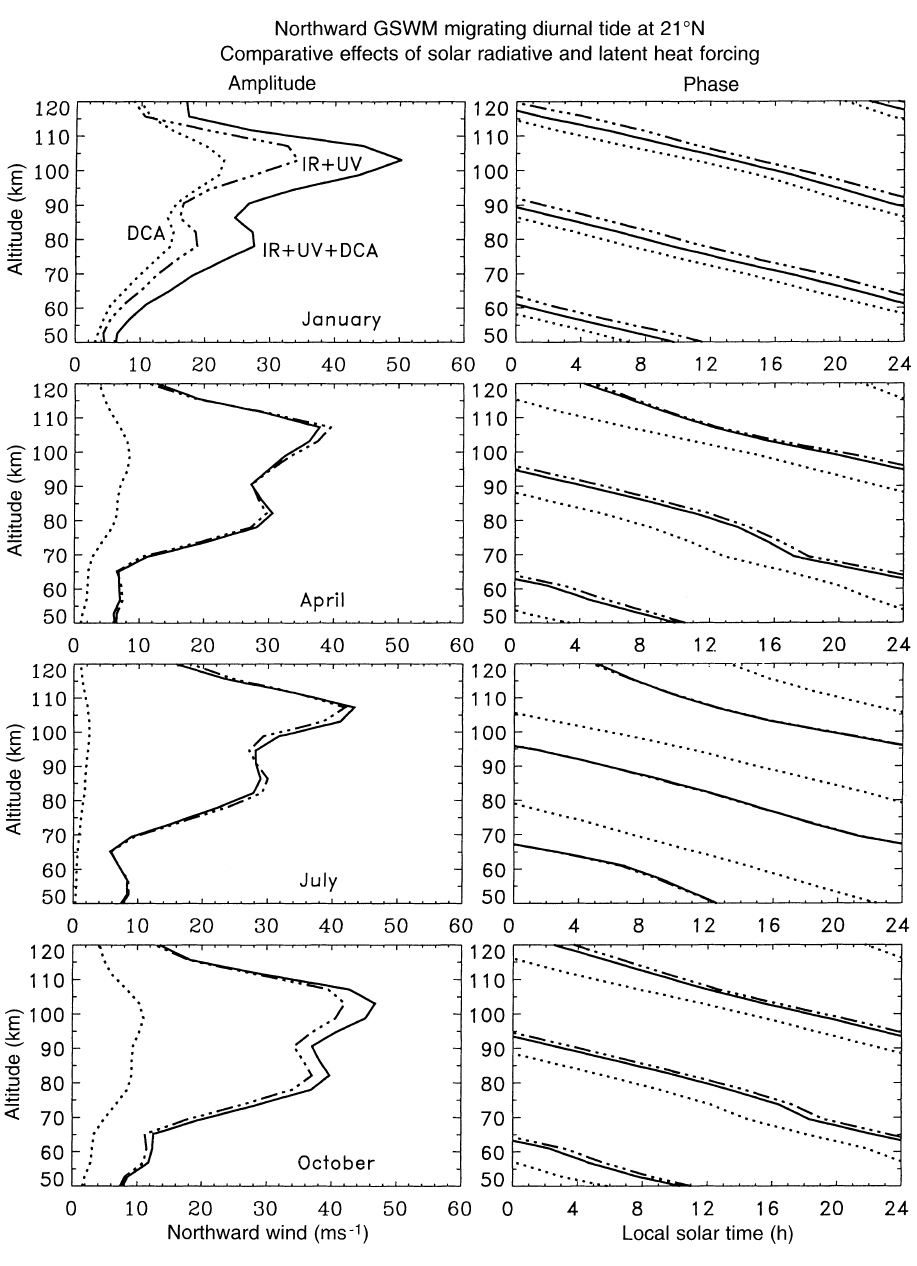
Fig. 7. Altitude profiles of migrat- ing diurnal northward wind ampli- tude ( left column ) and phase ( right column ) at 21 (cid:176) N during January ( top row ), April ( 2nd row ), July ( 3rd row ), and October ( bottom row ) for tropospheric DCA ( dotted curves ), combined IR and UV ( dot-dashed curves ), and all three ( solid curves ) tidal